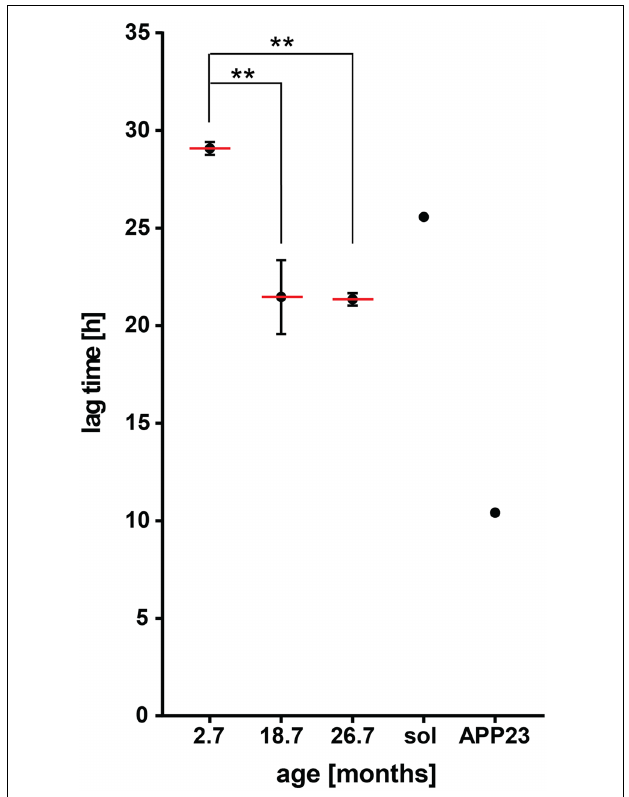
FIGURE 4 | Insoluble protein extracts from aged wild-type mouse brains seed A β aggregation in vitro . Lag times measured for A β aggregation in the presence of 0.001 µ g detergent-insoluble protein extracts from wild-type mouse brains at different ages. Mean values (red lines) with respective SEM of three biological replicates (each including five technical replicates) from on average 2.7, 18.7, and 26.7 month-old mouse brain insoluble extracts. Lag time of an 18 month-old mouse brain soluble extract (sol, negative control) and a 20 month-old mouse brain insoluble extract from an APP23 transgenic mouse (APP23, positive control). One-way ANOVA: 2.7 months vs. 18.7 months ∗∗ p = 0.0073, 2.7 months vs. 26.7 months ∗∗ p =